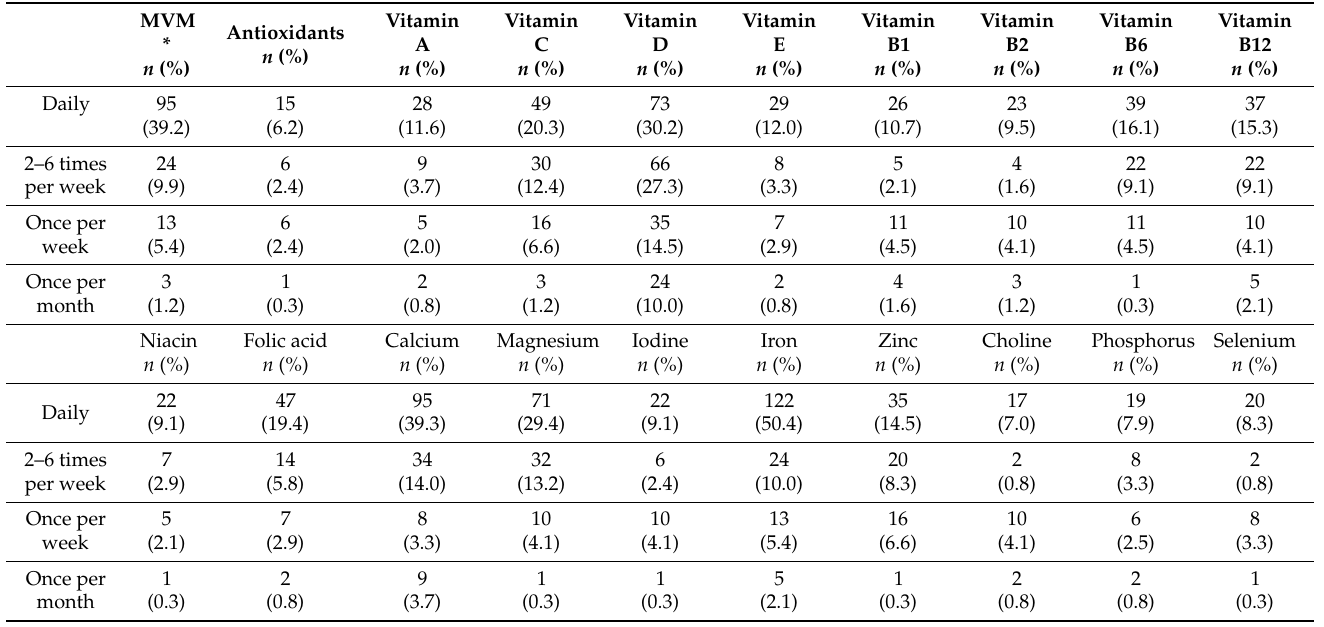
Table 3. The frequency and duration of use of single vitamin/or mineral and multi-vitamin-mineral supplements among mothers.